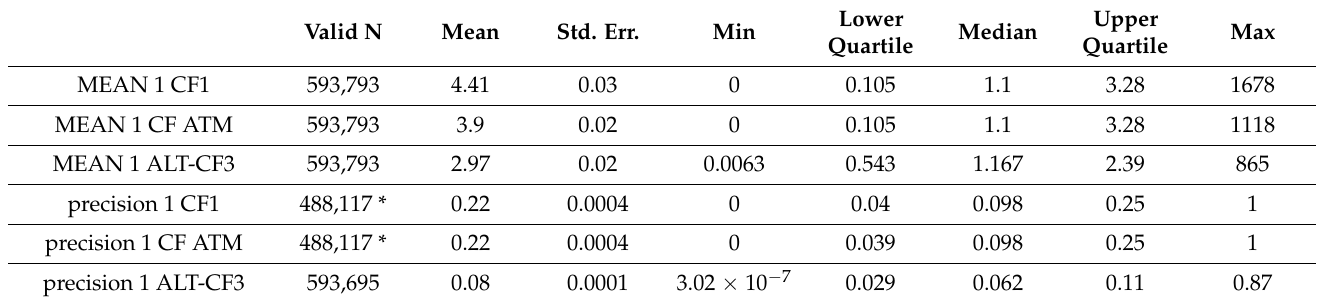
Table 2. All PM 2.5 data from Monitor 1 at the Oakmont site between 23 July 2019 and 28 September 2022.